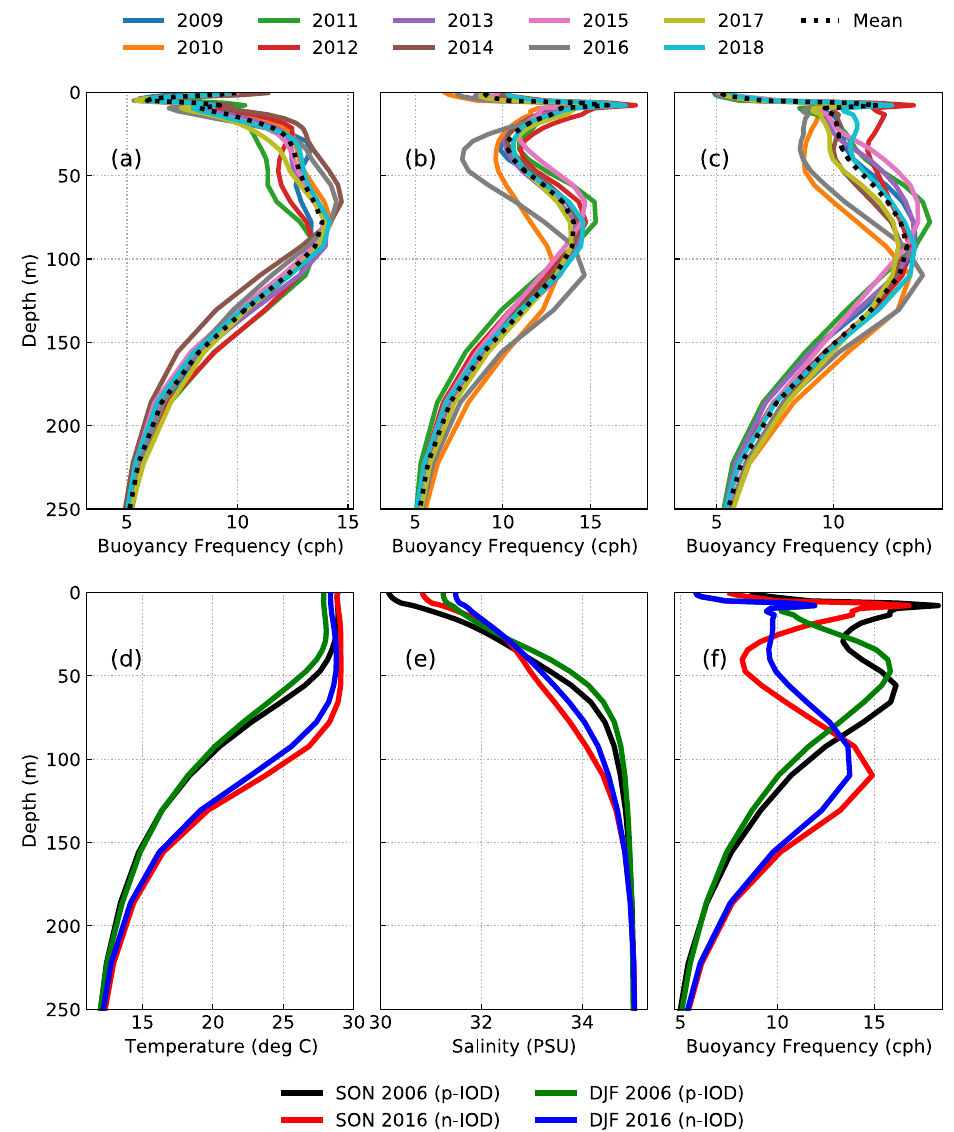
Figure 5. Mean buoyancy frequency profiles used in the set of experiments to quantify the effect of tidal forcing and stratification on the interannual variability of IT generation in ( a ) April, ( b ) October, and ( c ) December. Mean profiles of ( d ) temperature, ( e ) salinity, and ( f ) buoyancy frequency used in the set of experiments to study differences in IT generation, propagation, and dissipation between pIOD and nIOD. The legends for ( a ), ( b ), and ( c ) are shown on top, and the legends for ( d ), ( e ), and ( f ) are given on the